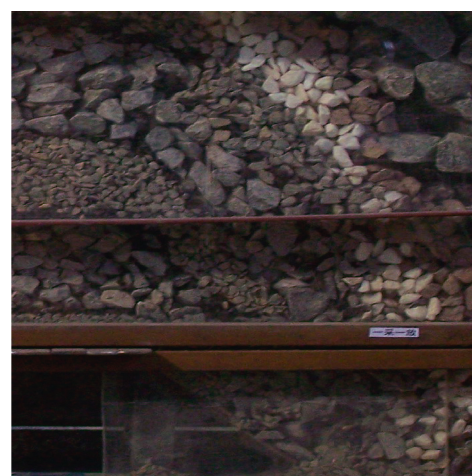
Figure 13: Arch during the flow of soft and hard